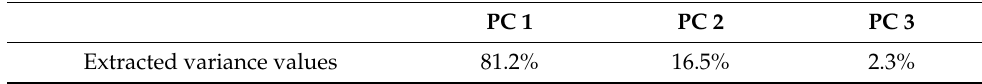
Table 6. Extracted variance values for each